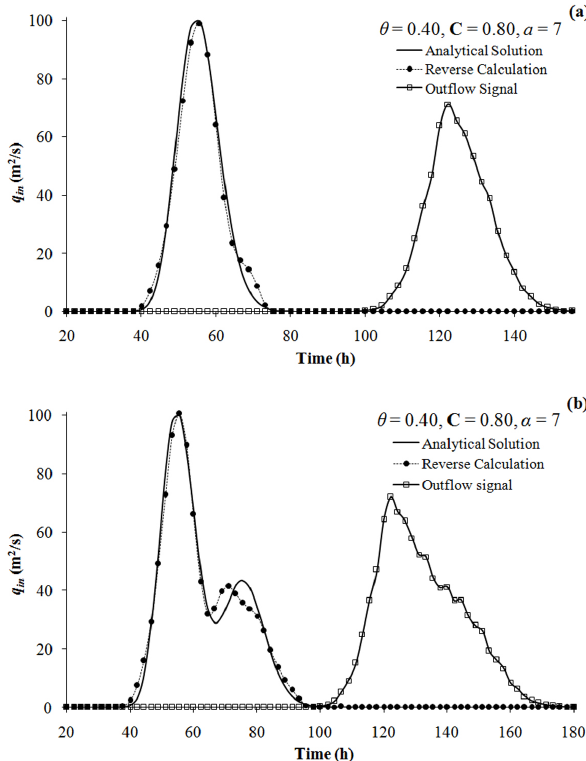
Fig. 10. Reverse flood routing with optimisation of outflow data seeded with 10%-error: (a) single-peaked signal, (b) double- peaked